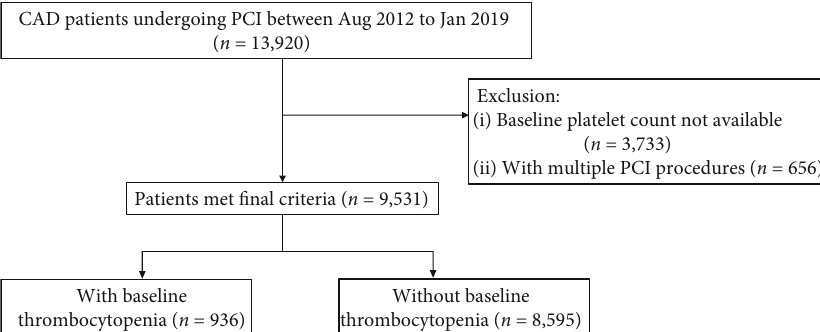
Figure 1: Study fl owchart describing inclusion and exclusion criteria leading to the fi nal cohort of patients. CAD: coronary artery disease; PCI: percutaneous coronary